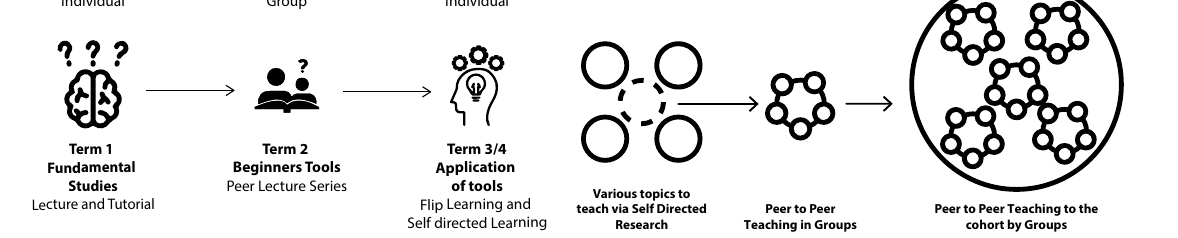
Figure 4: An overview of the "Peer Tutor Lecture Series." It is a